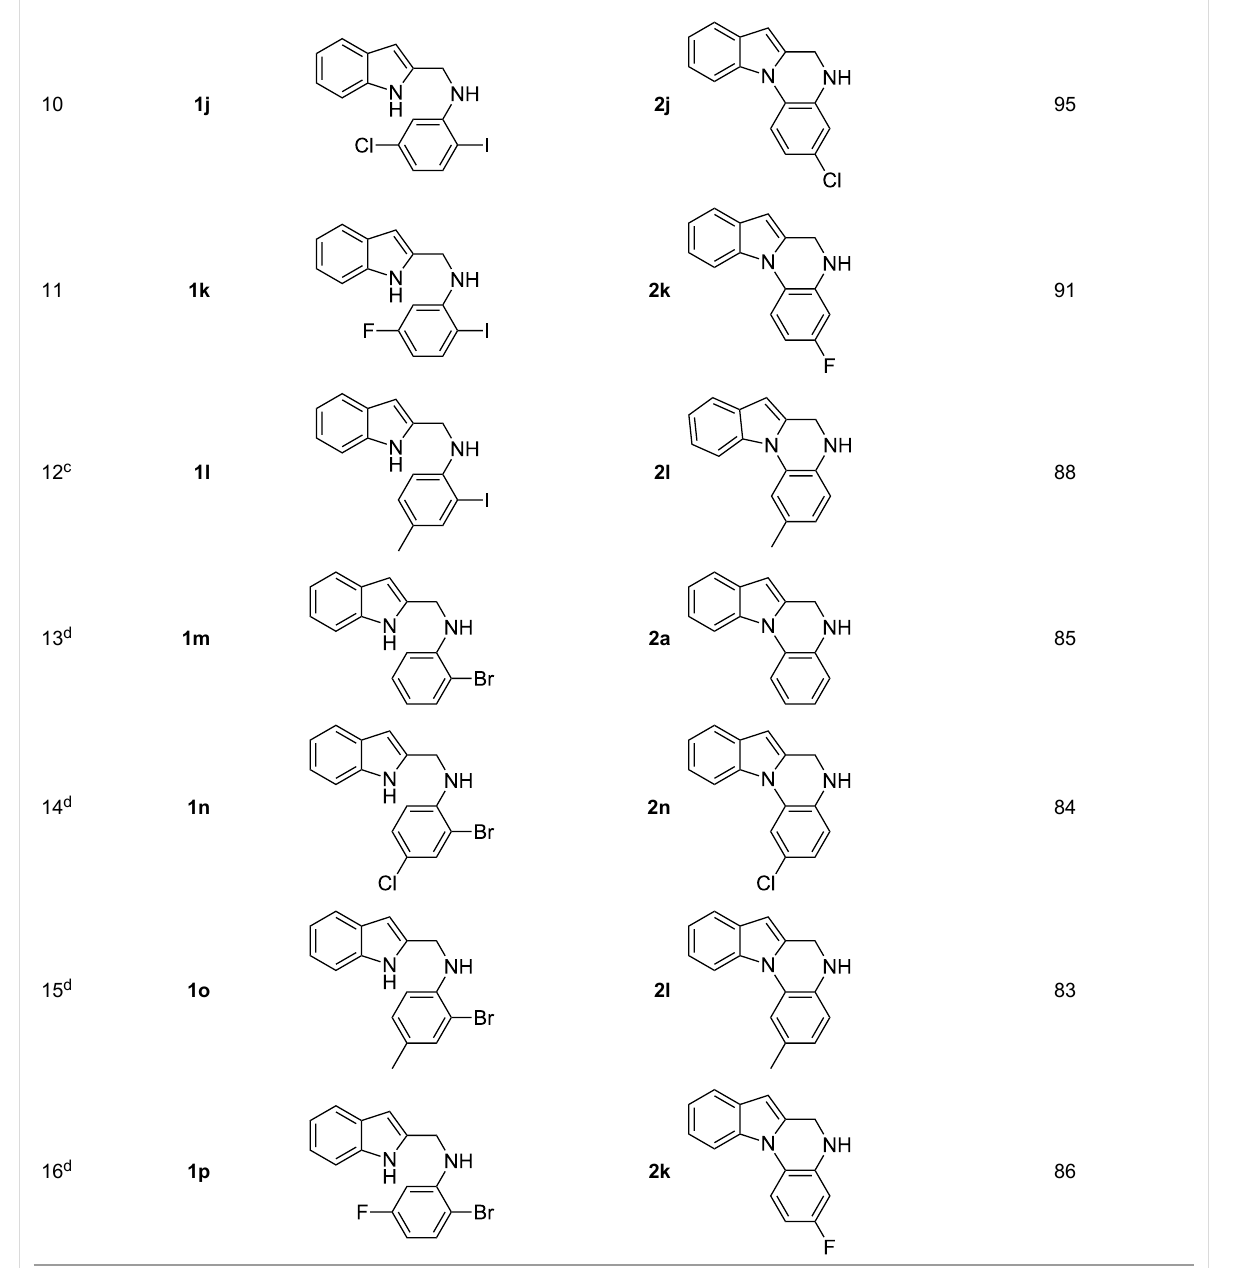
Table 2: Synthesis of 5,6-dihydroindolo[1,2- a ]quinoxalines by CuI-catalyzed intramolecular N-arylation. a